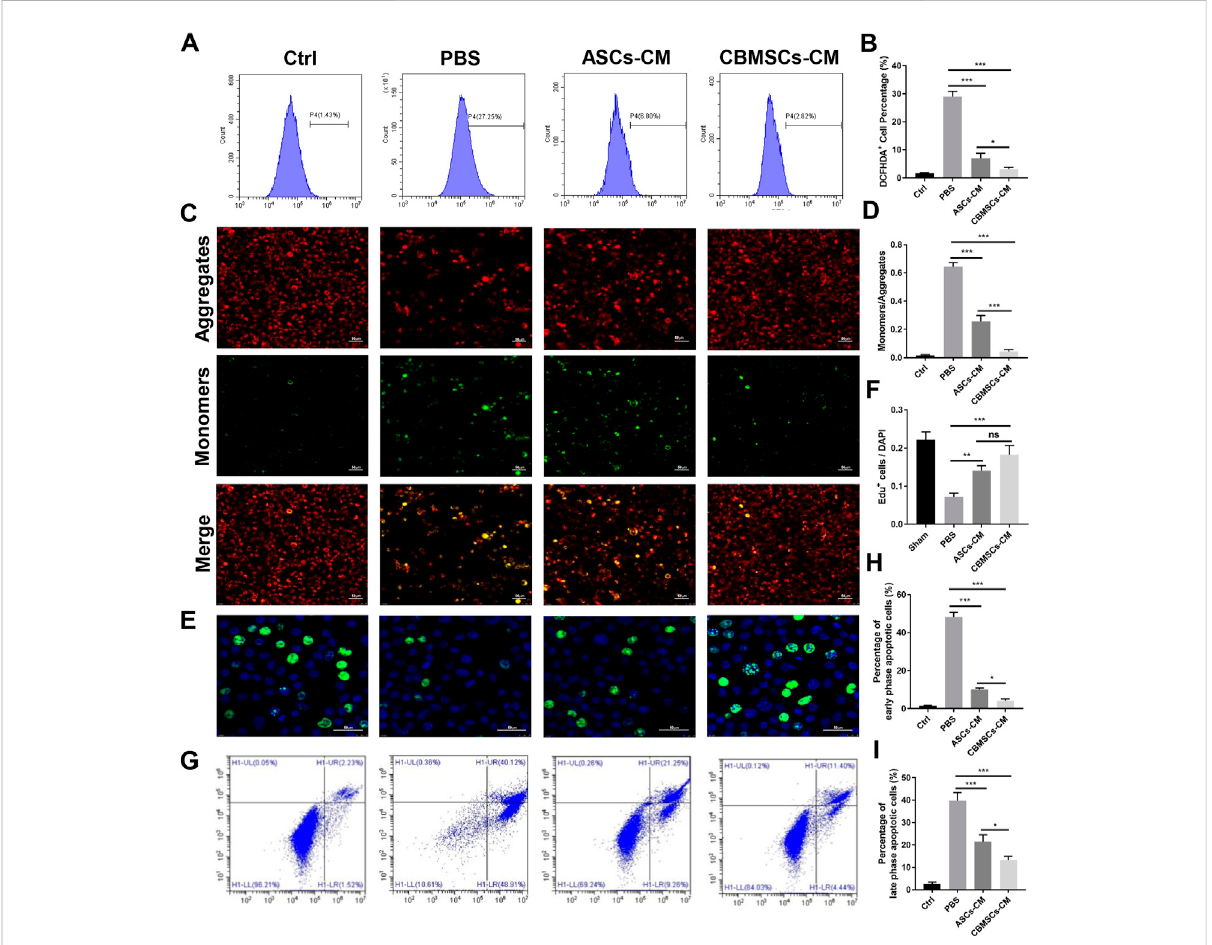
FIGURE 5 Effects of CBMSC-CM and ASC-CM on Schwann cells and CCSMCs in vitro . (A) Intracellular ROS in Schwann cells were detected by fl ow cytometry after treatmentwith CBMSC-CM orASC-CMandstimulationwith H 2 O 2 . (B) Statisticalanalysis ofROS inSchwann cells. (C) Schwann cells in an early apoptotic state were assessed by mitochondrial membrane potential staining. Representative images are shown. (D) Statistical analysis of Schwann cells in the early apoptotic state. (E) Proliferating Schwann cells were measured by EdU staining after CBMSC-CM or ASC-CM incubation and H 2 O 2 stimulation. (F) Statistical analysis of EdU-positive Schwann cells. (G) Apoptosis of CCSMCs was examined by fl ow cytometry after CBMSC-CM or ASC-CM treatment and H 2 O 2 exposure. (H) Statistical analysis of early-stage apoptotic CCSMCs. (I) Statistical analysis of